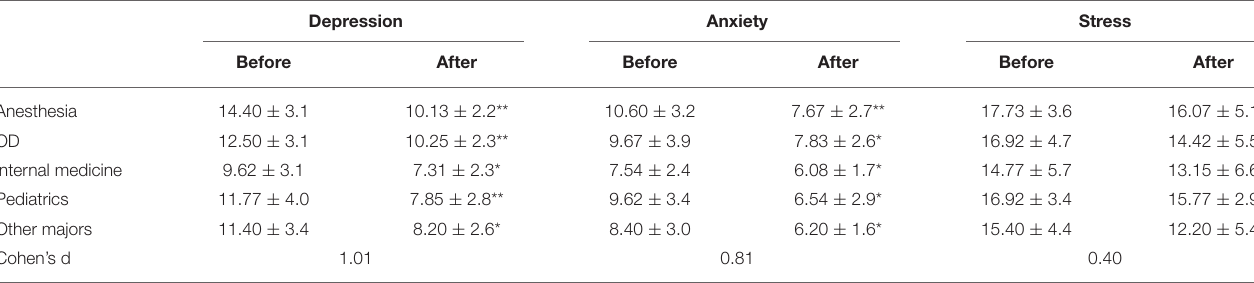
TABLE 4 | The comparison of DASS before and after psychological intervention among medical students from different majors. Depression Anxiety Stress Before After Before After Before After